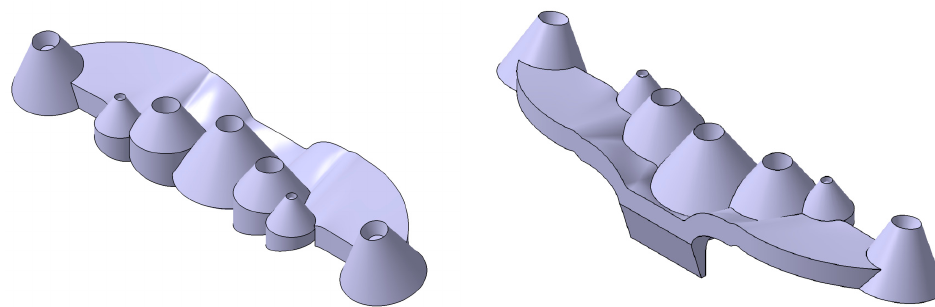
Figure 1. Collimating optical part.